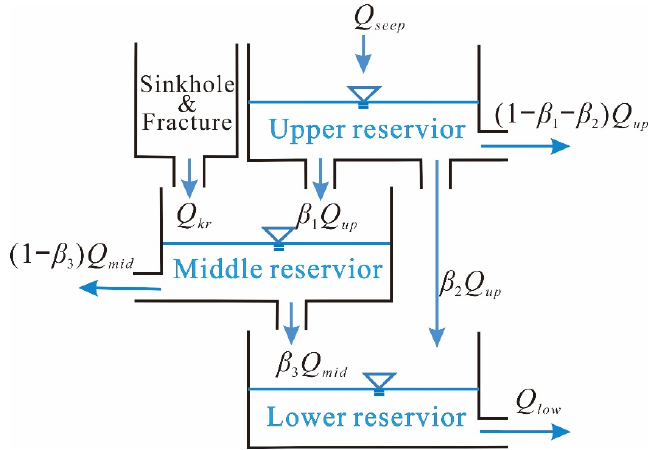
Figure 2. Conceptual model of the three improved reservoirs for recharge, transformation, and discharge of karst aquifers.